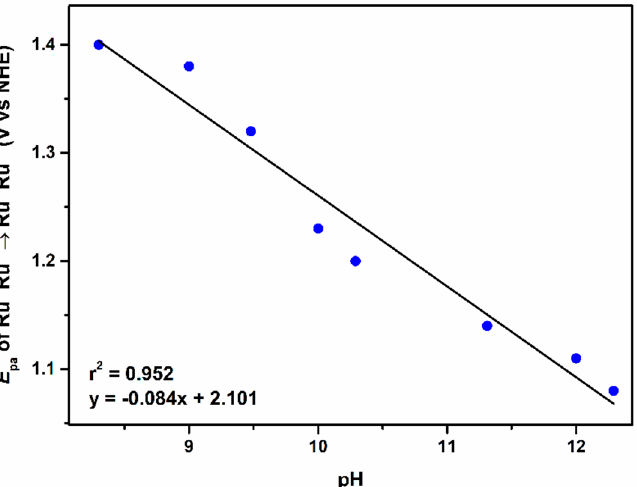
Figure 9. A plot of the anodic peak potential ( E pa ) of the Ru IV Ru IV /Ru IV Ru III redox couple vs. the pH of the medium. The voltammograms are recorded in 1.0 mM Na 3 [Ru 2 ( µ- CO 3 ) 4 ] and 0.10 M NaHCO 3 aqueous solutions at different pHs with a scan rate of 50 mV·s − 1 under N 2 atmosphere.